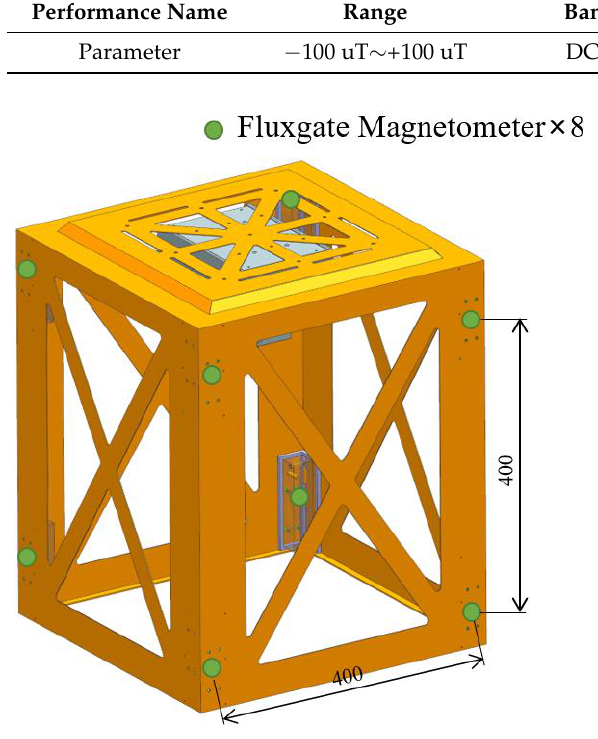
Figure 1. FMCAS diagram.